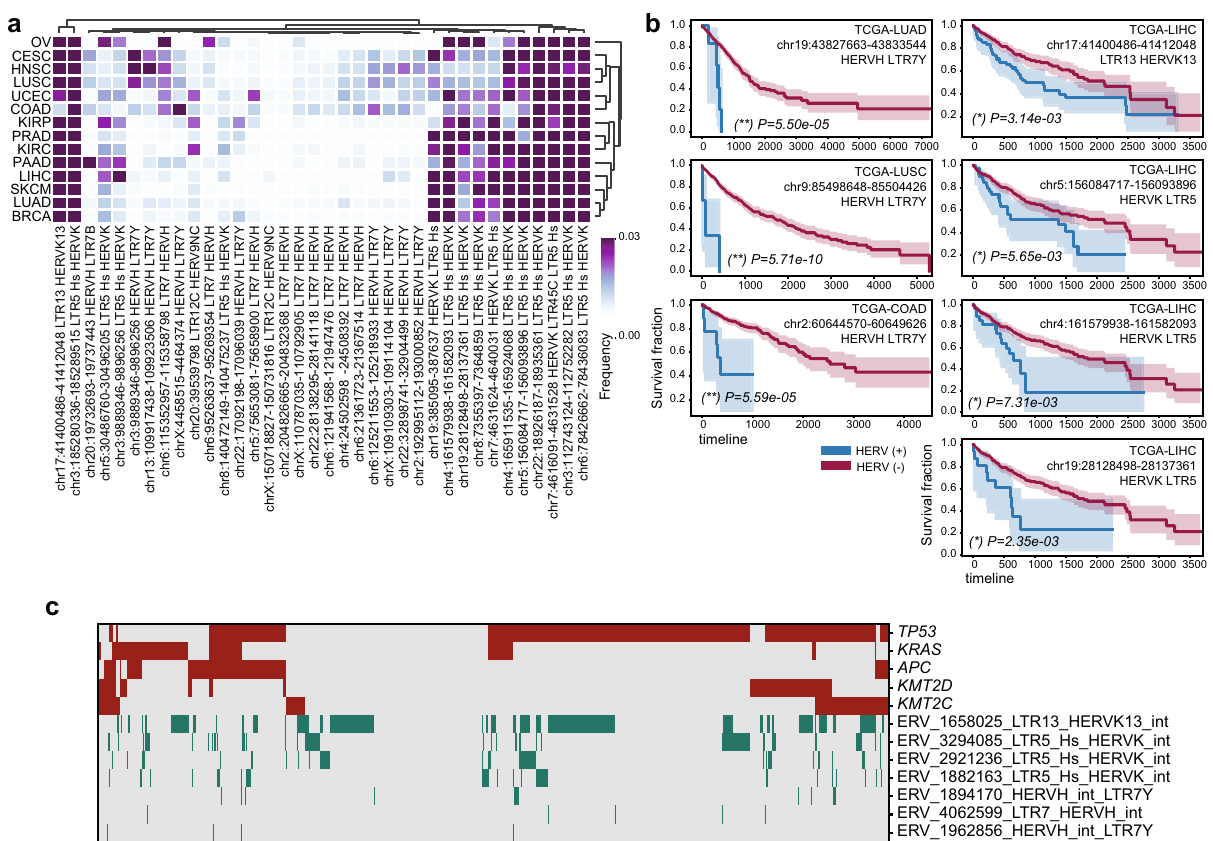
Fig. 3 | Human endogenous retroviruses(HERVs) expressed in different cancer types. a Heatmap clustogram clustering the proportion of HERVs across different tumortypes.Therowsare14TCGAtumortypes.The36columnsarethe36distinct HERVswiththehighestexpressioninhumancancers,mappedtouniqueregionsin the genome (Supplementary Data 5). b Selection of Kaplan – Meier curves com- paring the survival rates between patients in which any HERV reads were detected (bluecurves)versusthoseinwhichnoHERVreadsweredetected (redcurves).The unadjusted two-sided log-rank p values are reported. (**) global FDR q <0.05, (*)